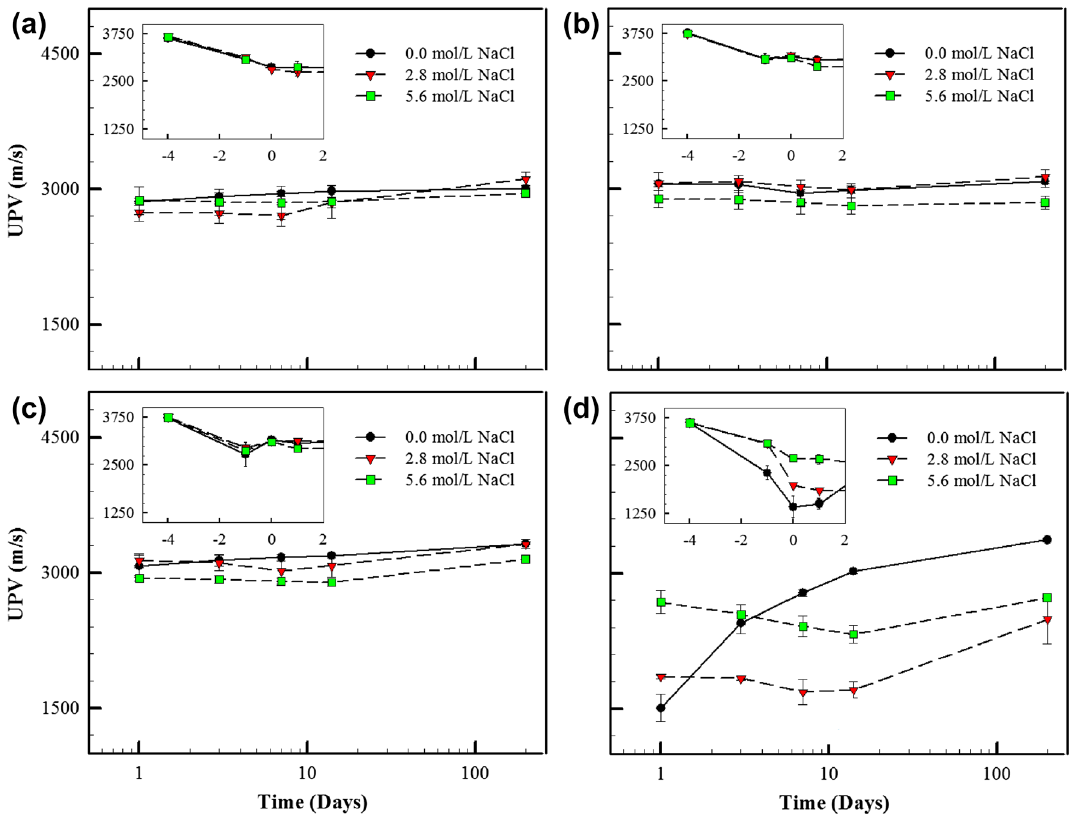
Fig. 7 UPVs in the following cement pastes: a OPC, b 10SF, c 20FA, and d